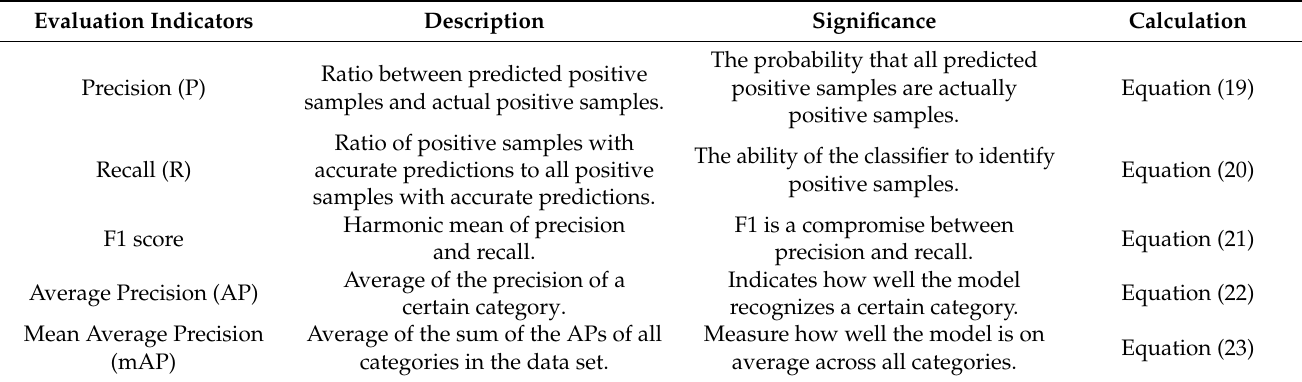
Table 3. The evaluation indicators of the model detection